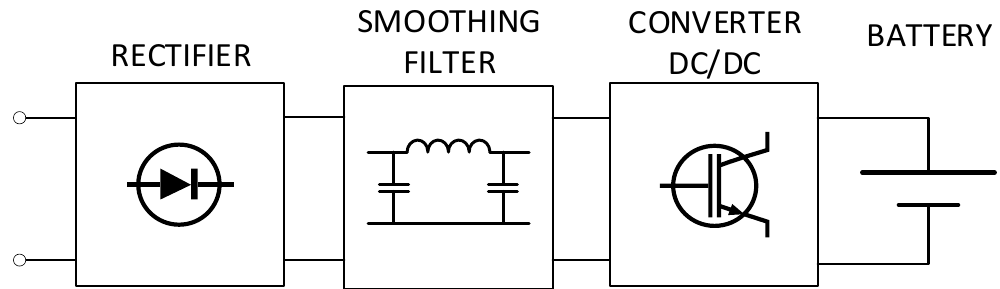
Figure 1. Block diagram of an electric vehicle charging system.